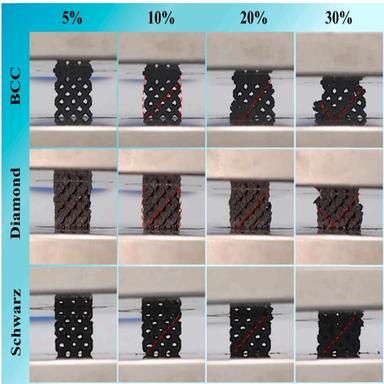
Deformation behavior of 2024-5 vol% TiCN lattice structures during compression testing.